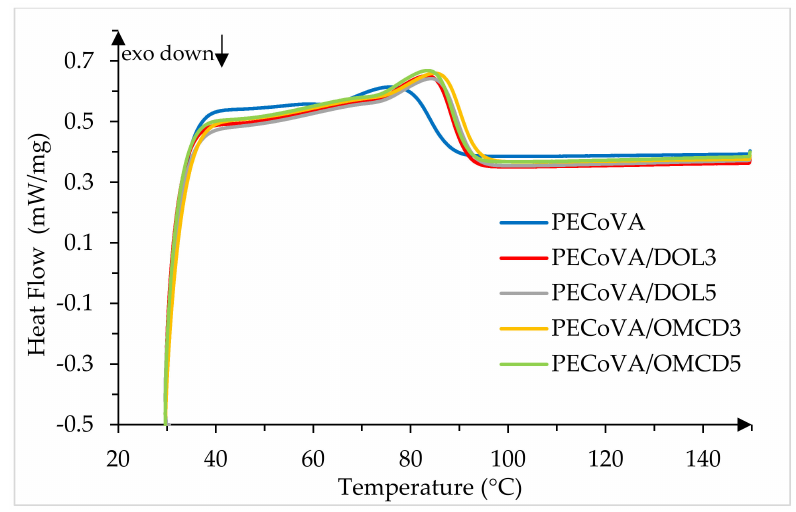
Figure 13. Effect of dolomite filler loading on the melting temperature, T m , of virgin PECoVA, PECoVA/DOL and PECoVA/OMCD